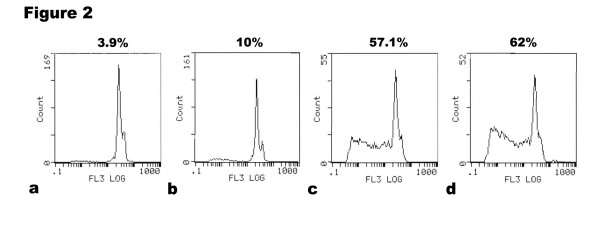
Induction of apoptosis on B16-F10 cells by CPT-TMC in vitro. Cellular apoptosis was verified by flow cytometric analysis. B16-F10 Cells were treated with (a) media-only, (b) TMC, (c) CPT, or (d) CPT-TMC, respectively. It is clear that the number of apoptotic cells in CPT-TMC and CPT treated group was significantly higher compared with other two groups. The apoptotic rate showed 62% in CPT-TMC-treated group versus 57.1% in CPT-treated group, 10% in TMC-treated group and 3.9% in media-only-treated group.